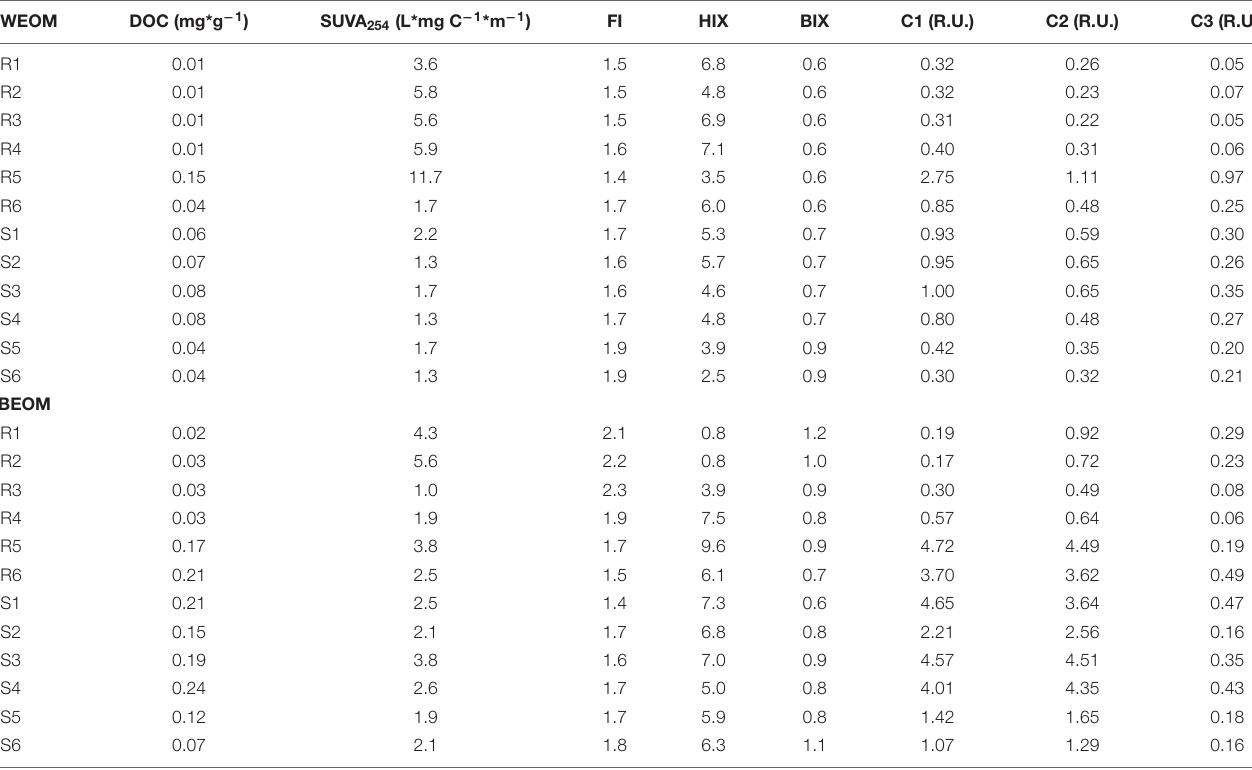
TABLE 2 | DOC concentrations, optical indicators, and fluorescence intensities of the WEOM and BEOM.